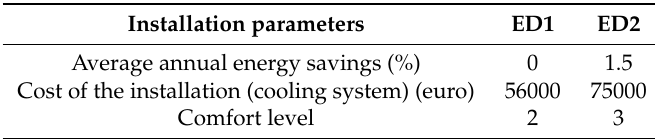
Table A4. Installation parameters—end devices